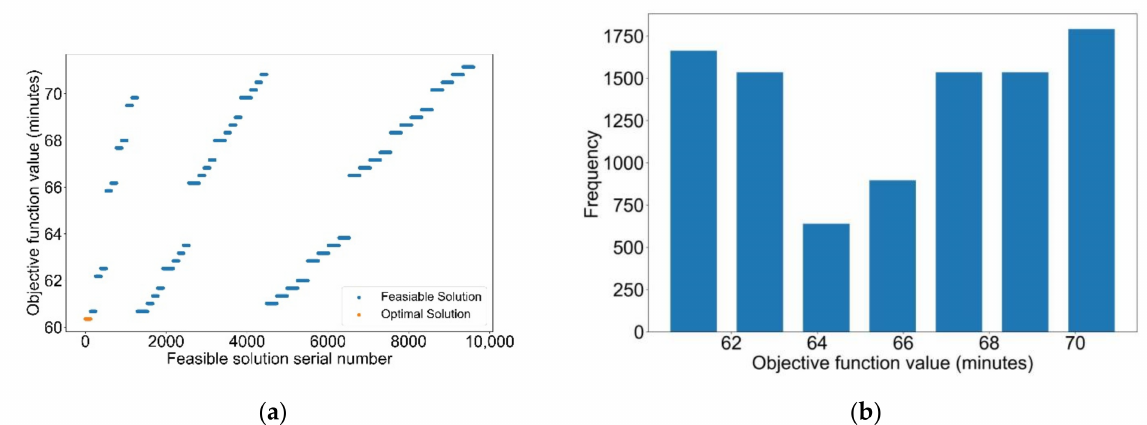
Figure 12. Diagram of feasible solutions: ( a ) Distribution of objective function values of feasible solutions; ( b ) Histogram of objective function values of feasible solutions.